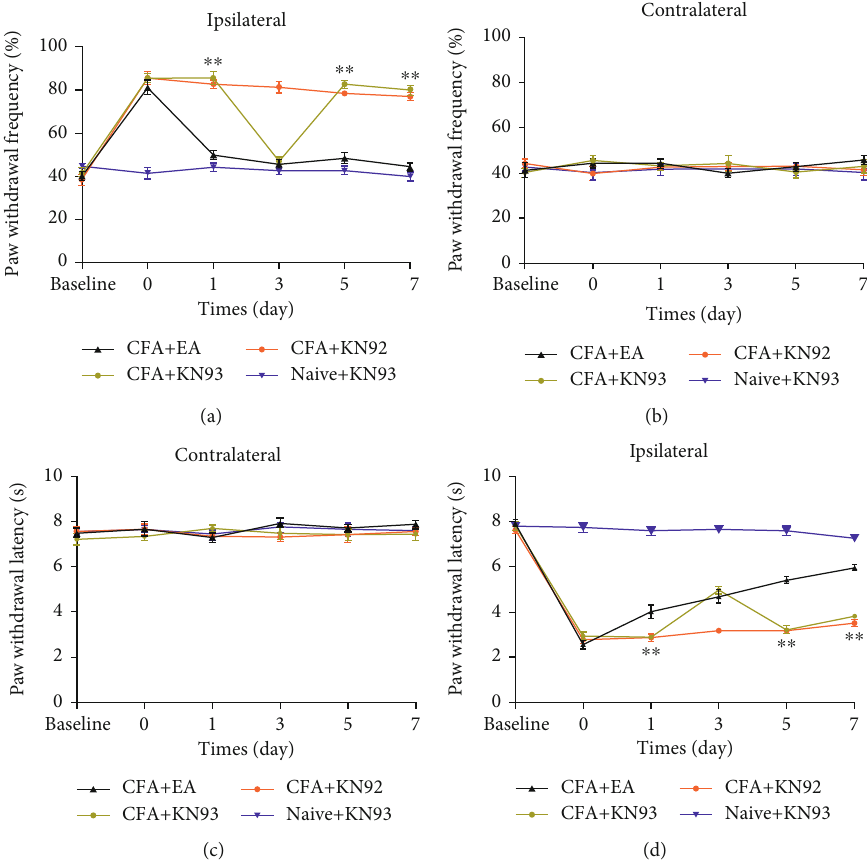
Figure 4: E ff ects of inhibitor on mechanical and thermal pain threshold ( n = 7 /group). KN93 was given on the third day of CFA injection. The paw withdrawal threshold was tested at base, 1 day, 3 days, 5 days, and 7 days. (a) The paw withdrawal frequency of the CFA+ KN93 group was increased after KN93 injection (3 days), compared with the CFA+EA group on the ipsilateral side. KN92 has no e ff ect on paw withdrawal frequency. (c) The paw withdrawal latency of the CFA+ KN93 group was increased after KN93 injection (3 days), compared with the CFA +EA group on the ipsilateral side. KN92 has no e ff ect on the paw withdrawal latency. (b, d) No di ff erence among the 4 groups on the contralateral side. ∗ P < 0 : 05 , ∗∗ P < 0 : 01 vs. CFA +EA